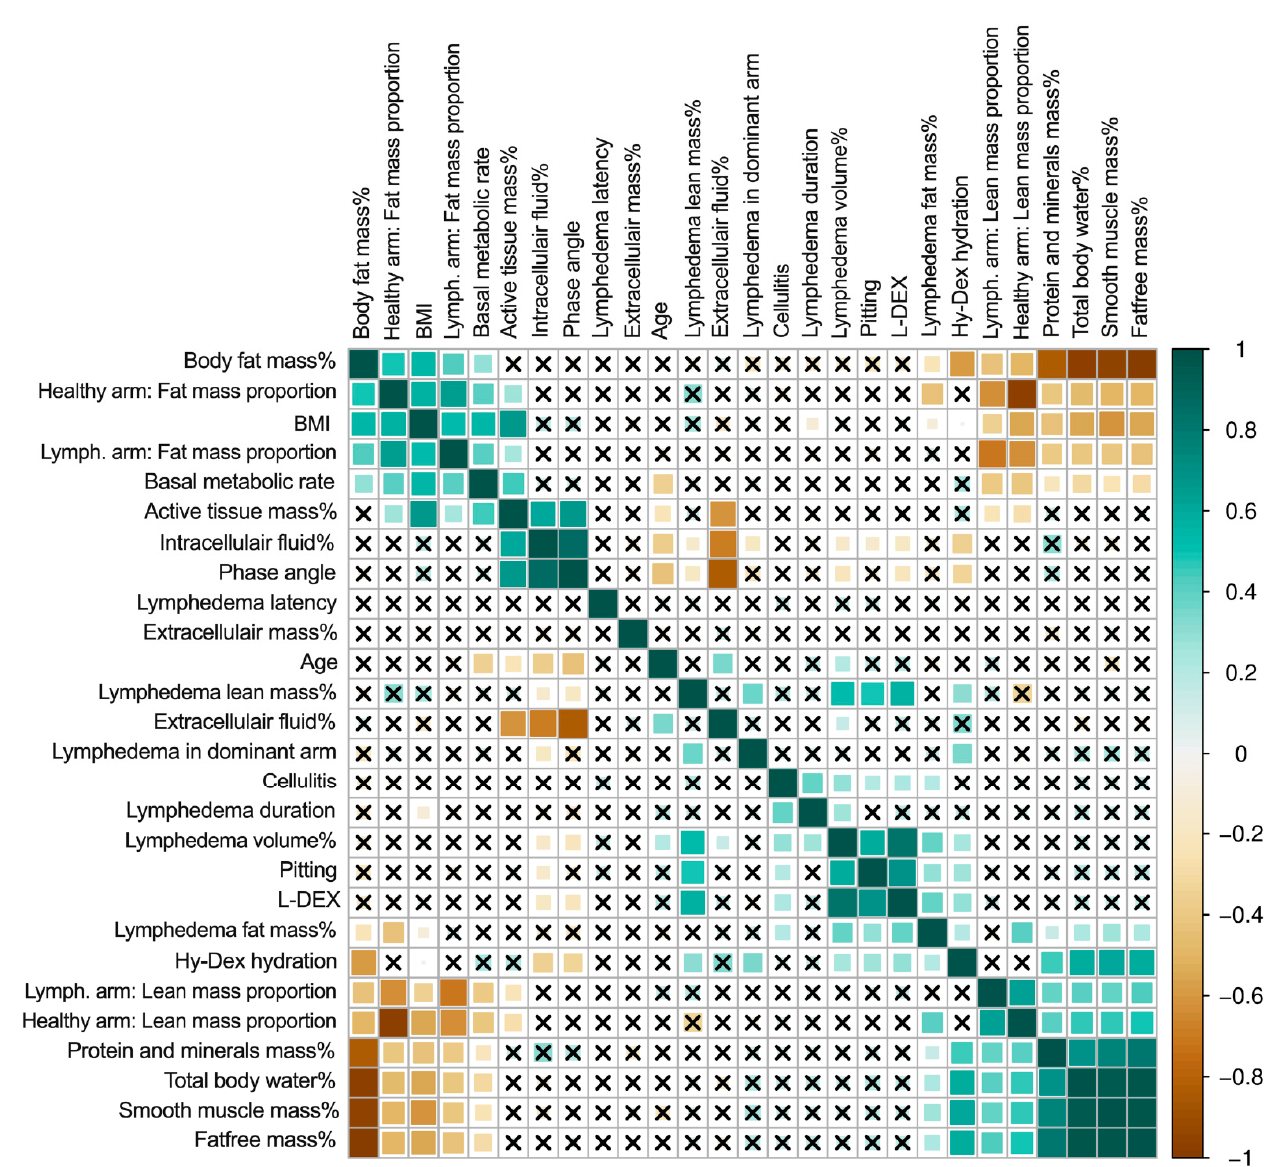
Figure 2. Correlation matrix of lymphedema and patient variables. This figure shows the correlation matrix between all variables. The darker green color denotes a stronger positive correlation, and the darker brown color denotes a stronger negative correlation. The squares with crosses denote that there is no significant correlation. Body fat mass %, basal metabolic rate, phase angle, intracellular fluid %, extracellular fluid %, extracellular mass %, total body water, protein and minerals mass %, Hy-Dex hydration, smooth muscle mass %, total body water %, active tissue mass%, and fat-free mass % are derived from whole-body analysis using bioimpedance. Lymphedema volume %, lymphedema lean mass %, and lymphedema fat mass %, lymph.arm: lean mass proportion, lymph.arm: fat mass proportion, healthy arm: lean mass proportion, healthy arm: fat mass proportion are regional analysis derived from DEXA scans. BMI = body mass index. Lymph. = lymphedema.